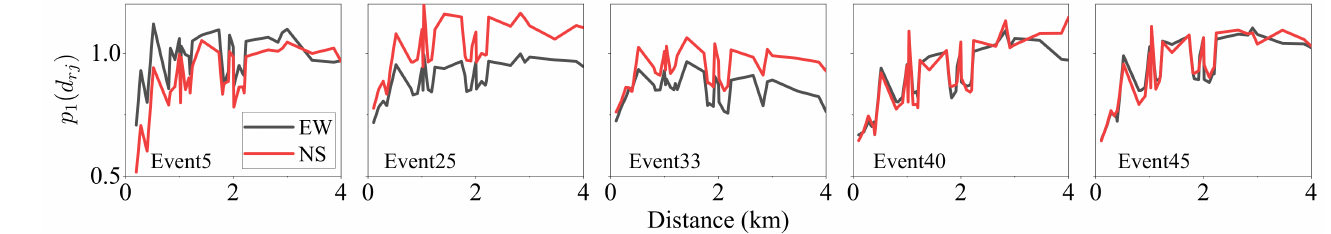
(cid:16) (cid:17) d rj Figure 11. of the horizontal components. As shown in Figure 11, all the lines have similar peaks and troughs at the same separation distance, which might involve a certain mechanism that is not within the scope of this study. All the lines have an increasing trend with the increase in distance; the lines corresponding to Events 5, 25, and 33 reach their steady value, whereas those for Events 40 and 45 keep on increasing. The ordering of the increasing rate of the lines in Figure 11 is roughly the same as the rate of spectral similarity dropping. The difference is that the increasing rate is closer for the components in one event. In the left three figures of Figure 11, the lines have similar increasing rates but different amplitudes. According to the line shapes in Figure 11, p ( d rj , f ) is assumed to have the form of Equation (5).